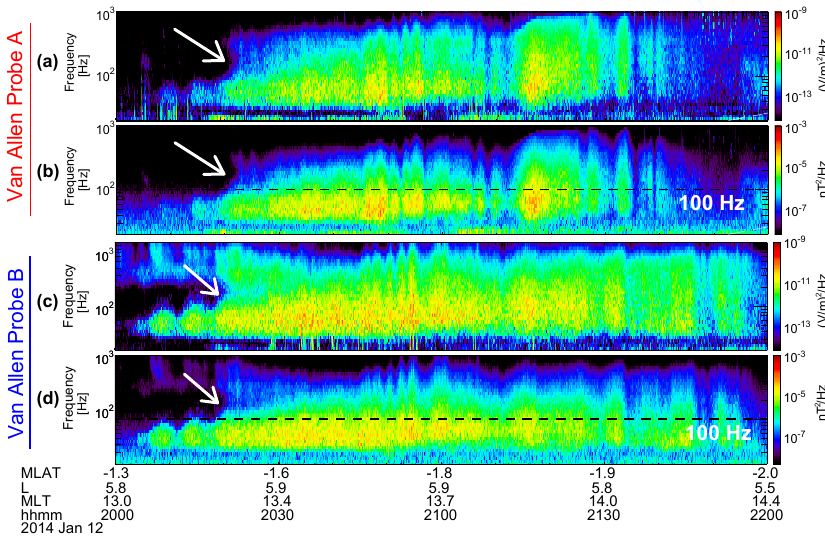
Figure 7. The wave electric (a) and magnetic (b) spectral density observed by Van Allen Probe A and the wave electric (c) and magnetic (d) spectral density from Van Allen Probe B. Note that at the beginning of the emissions around 20:20UT, the hiss wave intensity as a function of frequency presents a minimum at ∼ 200Hz (white arrows) for the observations from both Van Allen probes A and B.